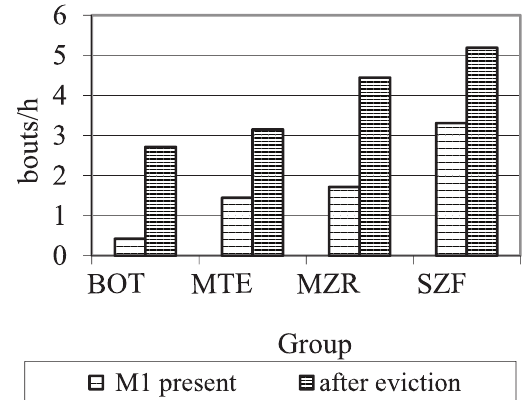
Figure 3. Guarding (bouts/h) by M in groups BOT1 MTE MZR SZF.